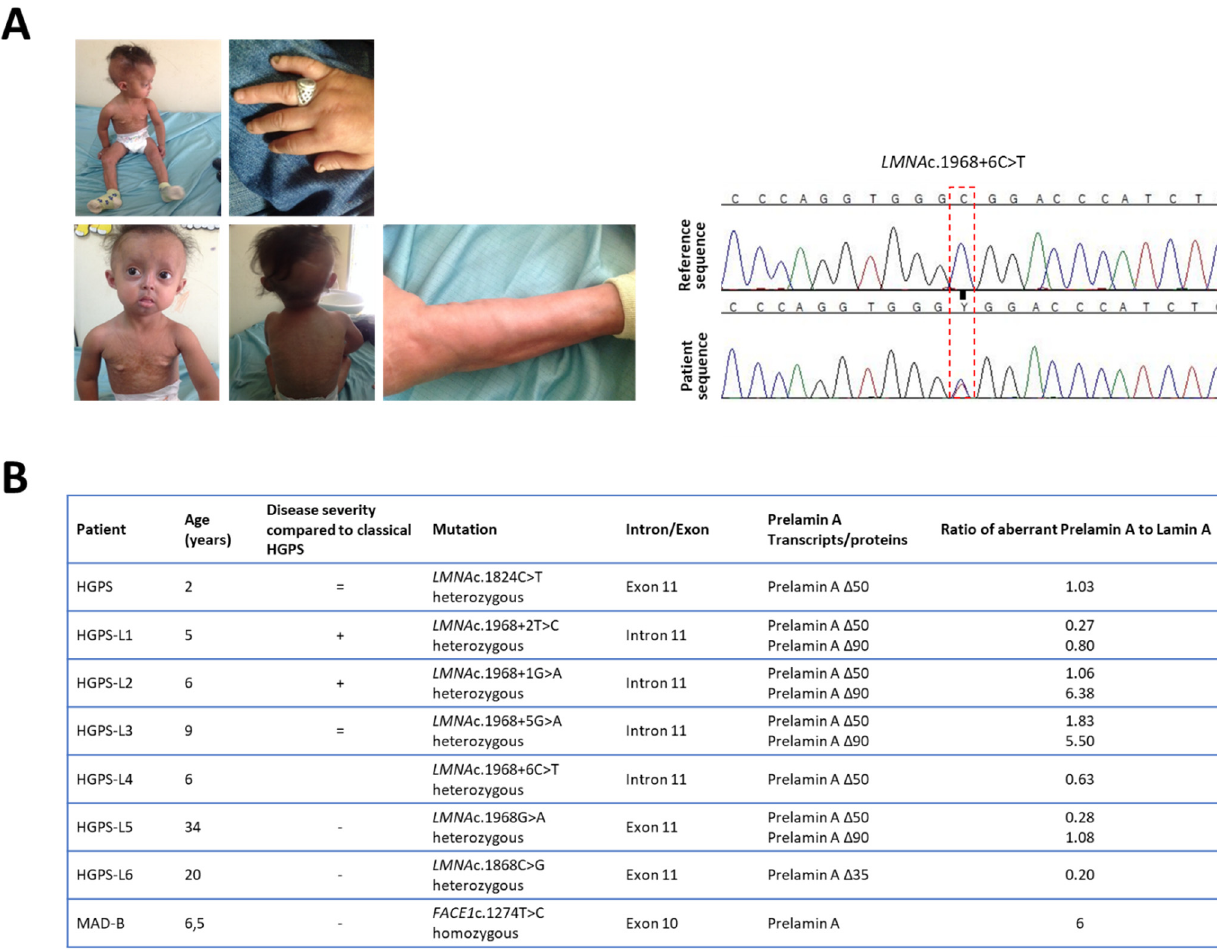
Figure 1. Clinical and molecular description of cell lines. ( A ) Pictures and electropherograms of pa- tient HGPS-L4 at age 6 years showing progeroid features, including sparse hair and eyebrows, small chin, a thin nose, prominent nipples, dyspigmentation with hyper/hypo-pigmented areas, and scle- rodermatous changes on her chest. The heterozygous c.1968+6C>T LMNA mutation was confirmed by Sanger sequencing. ( B ) Characterization of LMNA and FACE1 (ZMPSTE24) gene mutations in HGPS-like and MAD-B patients eliciting aberrant prelamin A splicing or wild-type prelamin A ac- cumulation. Variable disease severities compared to classical HGPS are indicated with “+”: more, “ − “: less, or “=”: equal severity. The ratios of aberrant prelamin A to lamin A isoforms are shown,